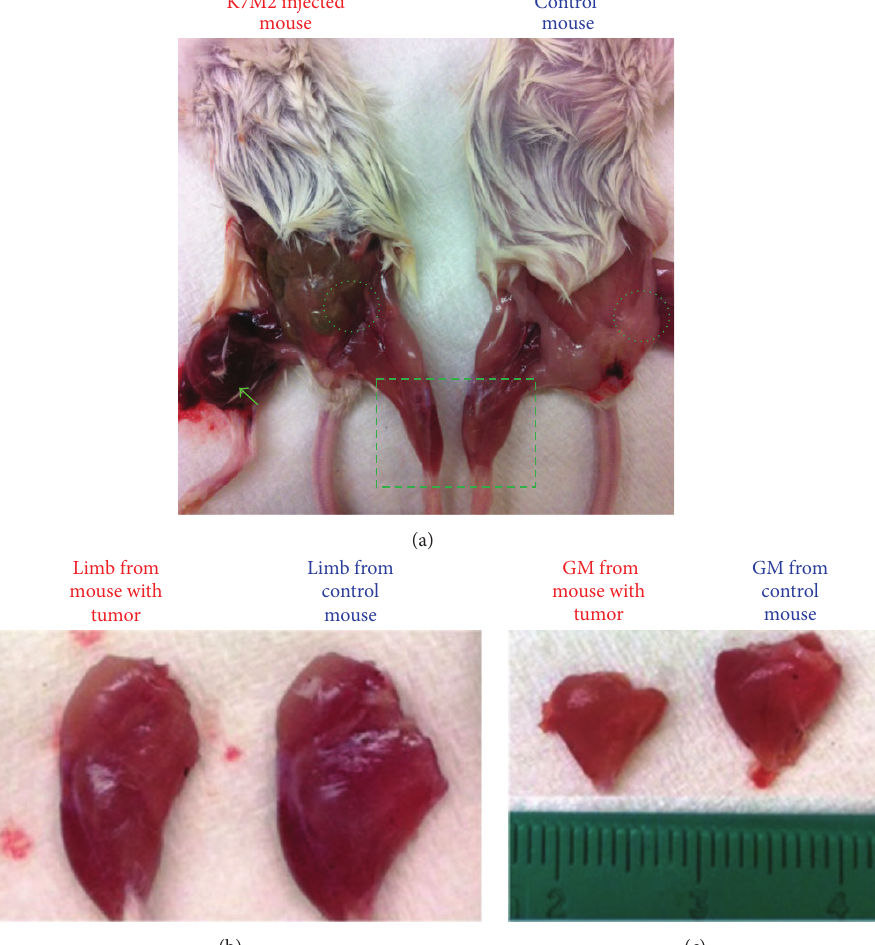
Figure1:Cancercachexiainosteosarcoma-bearingmice.(a)SixweeksaftertheinjectionofK7M2cellsintotibiasofmice,tumordevelopment can be observed in right hindlimb (green arrow). The tumor-bearing mice showed smaller muscle size (outlined with rectangle) and reduced adipose tissue (outlined with circles). (b) Left hindlimbs from mice with and without tumor. (c) Gastrocnemius (GM) muscles from mice with and without